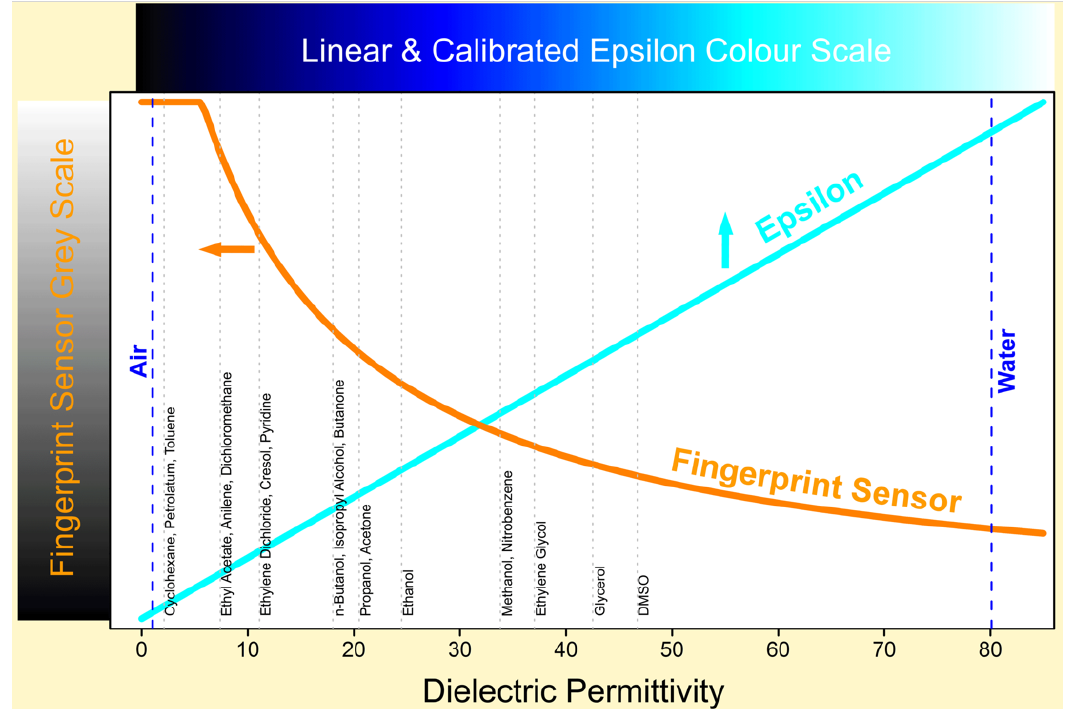
Figure 2. The Epsilon calibration curve and linear response to dielectric permittivity.